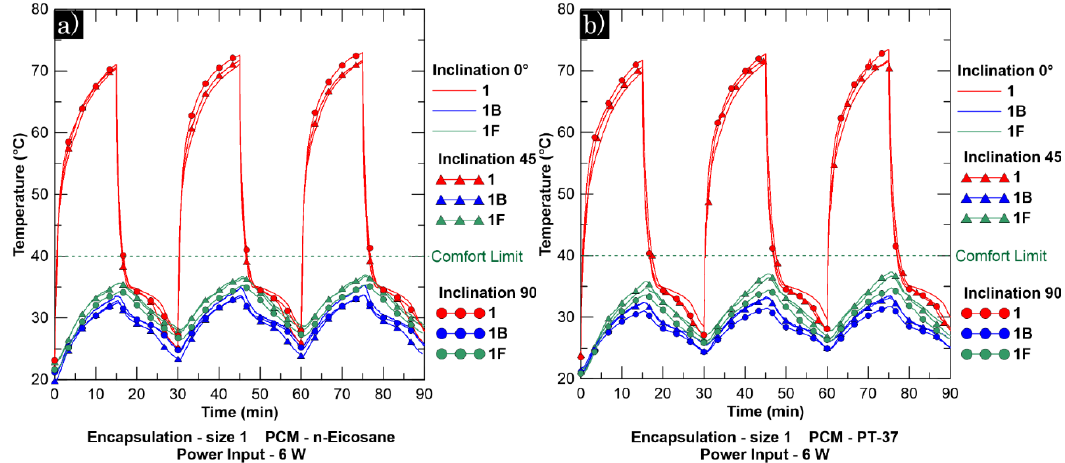
Figure 9. Influence of inclination on the thermal response of the experimental tablet PC at 6 W power input with Size 1 PCM TES Unit: ( a ) n- eicosane and ( b ) PT-37.